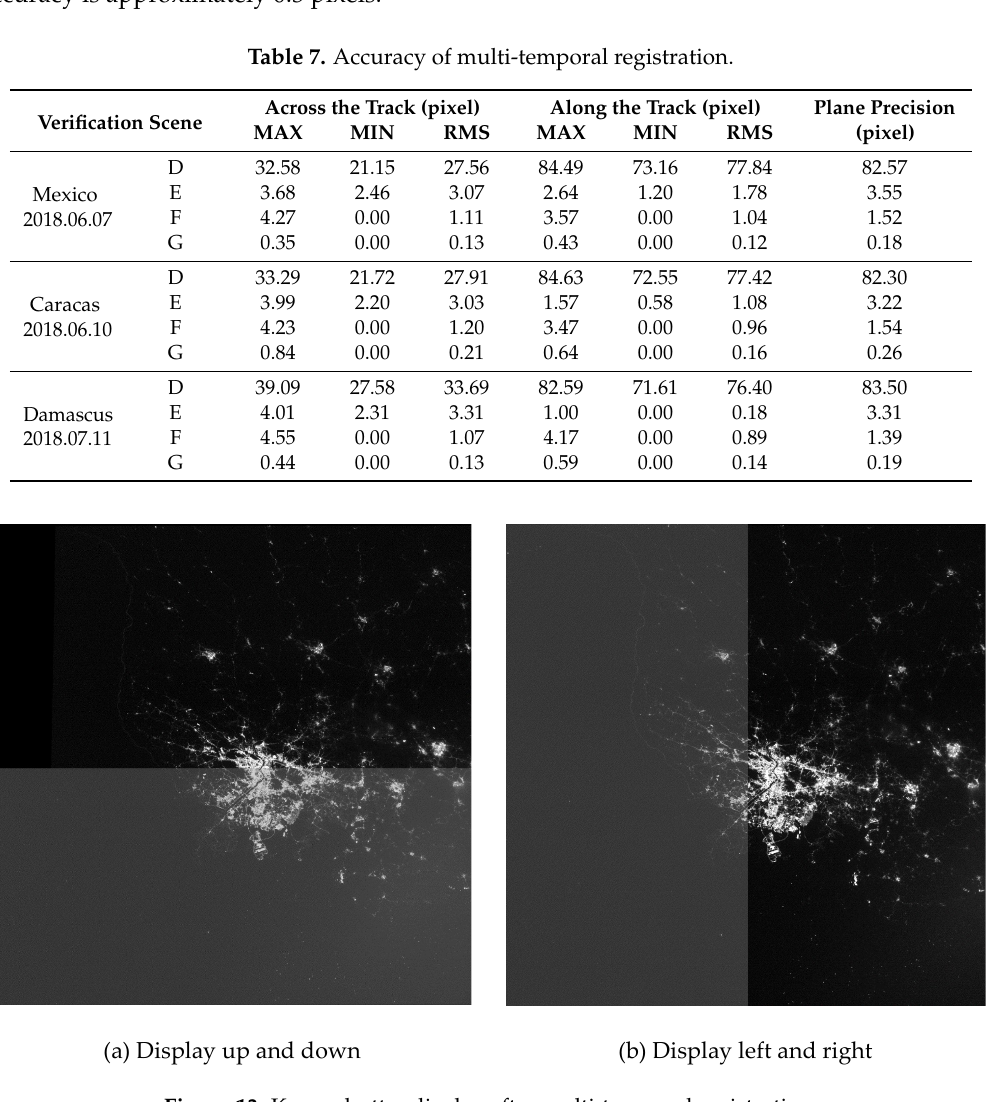
(b) Display left and right Figure 14. Shanghai shutter display after multi-temporal registration. 4. Conclusions On-orbit geometric calibration is particularly important to ensure the application of follow-up night-light images of LJ1-01. This paper introduces the on-orbit geometric calibration model of LJ1-01 in detail. Aiming at the difficulty of on-orbit geometric calibration of LJ1-01 night-light remote-sensing CMOS rolling shutter sensor without night-light calibration field, an on-orbit calibration scheme of "day calibration + night compensation" was proposed using LJ1-01 night-light CMOS rolling shutter sensor with daytime imaging ability. According to the dynamic imaging principle of the rolling shutter, a rigorous geometric imaging model of time-sharing exposure of the rolling shutter of LJ1-01 was constructed, and the effective compensation of daytime calibration